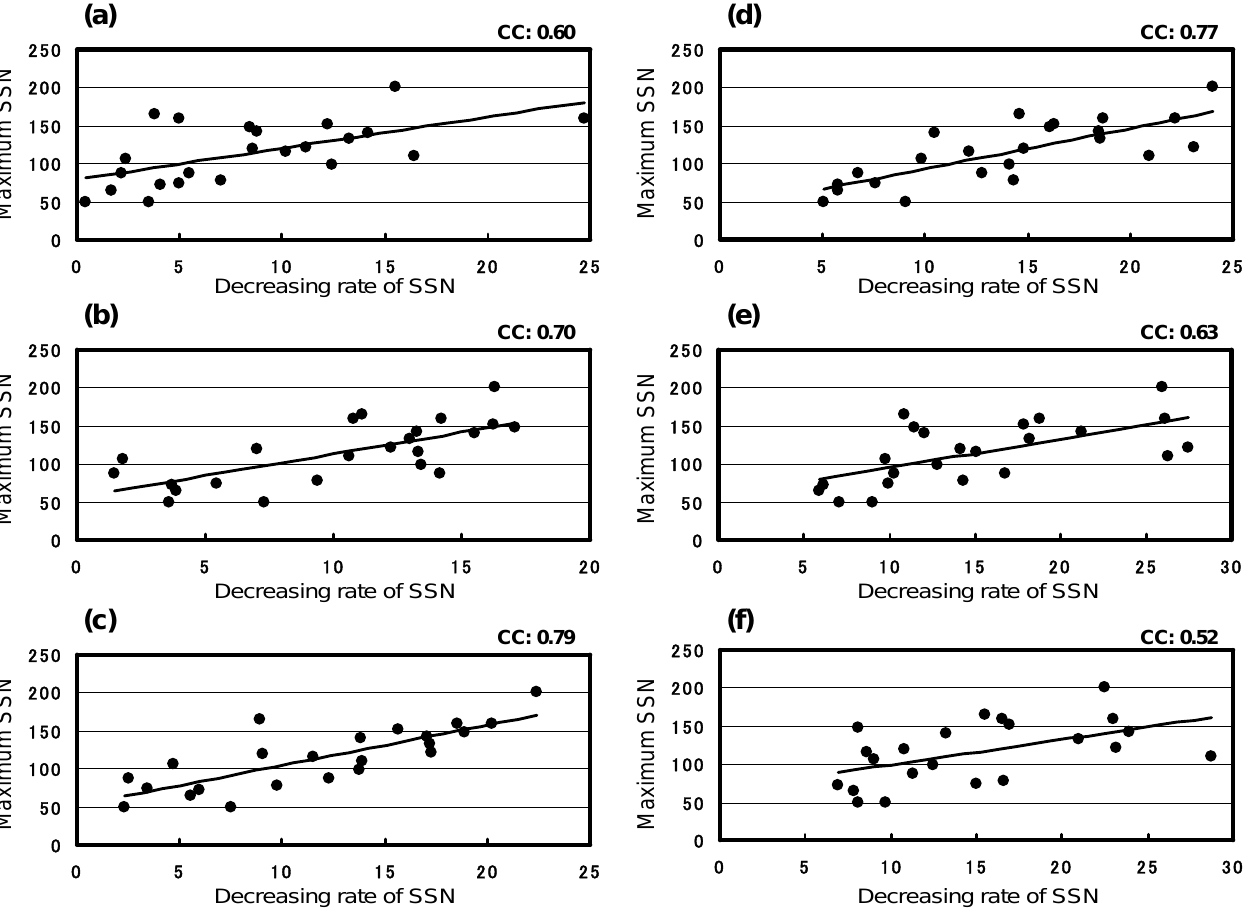
Fig. 1. (a) Peak sunspot number versus rate of decrease in the preceding cycle over a one-year period before the minimum. Panels (b) , (c) , (d) , (e) and (f) are the same as panel (a) but for two-year, three-year, four-year, five-year and six-year periods before the minimum,